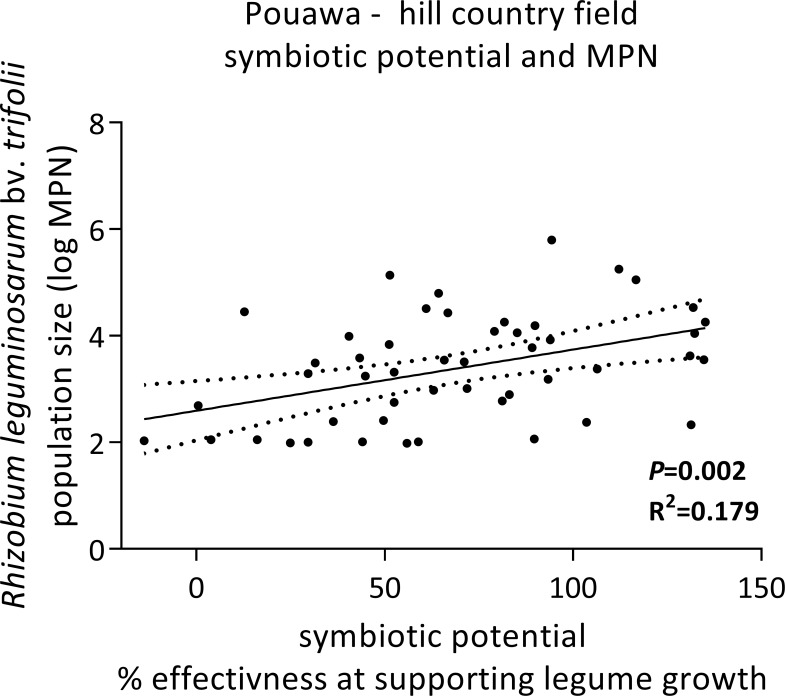
Relationship between the R. leguminosarum bv. trifolii population size and symbiotic potential of the legume-rhizobia symbiosis in 50 samples of soils collected from within a single field at Pouawa (hill country sheep and beef farm).Solid line is the linear regression model fit; dashed lines are the 95% confidence intervals.